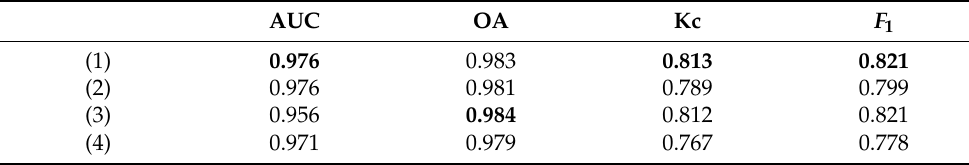
Table 8. Ablation study on the Shuguang dataset.